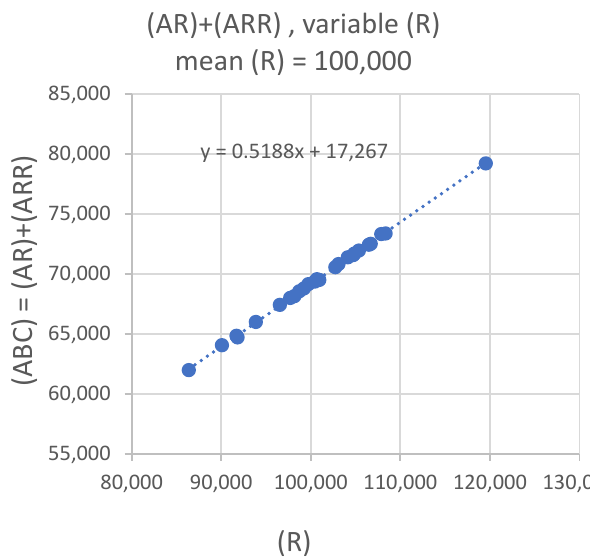
Figure 6. (AR) + (ARR) equilibrium values for the same calculation as in Figure 5 with the exception that the initial value of ® for each calculation is taken from a normal distribution, with a mean of 100,000 and a CV% of 6%. Note the scale of the y-axis in Figure 6 is much larger (5000 units per gradation) than the scale of y-axis in Figure 5 (50 units per gradation).